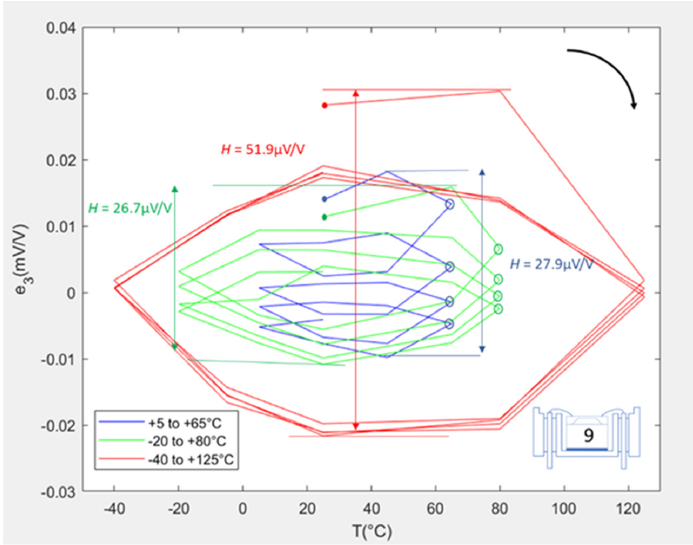
Figure 7. Error plots for SE #9 when L1 packaged.